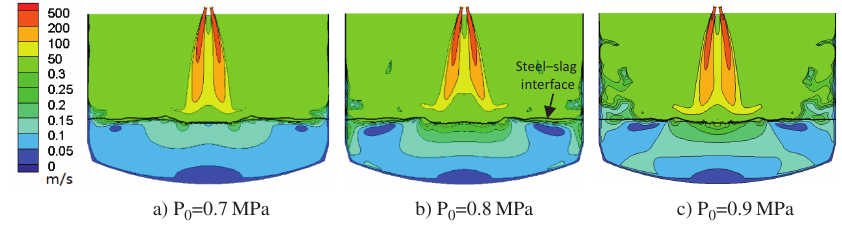
Figure 4: Converter ’ s velocity contour map of vertical section at different oxygen pressure.